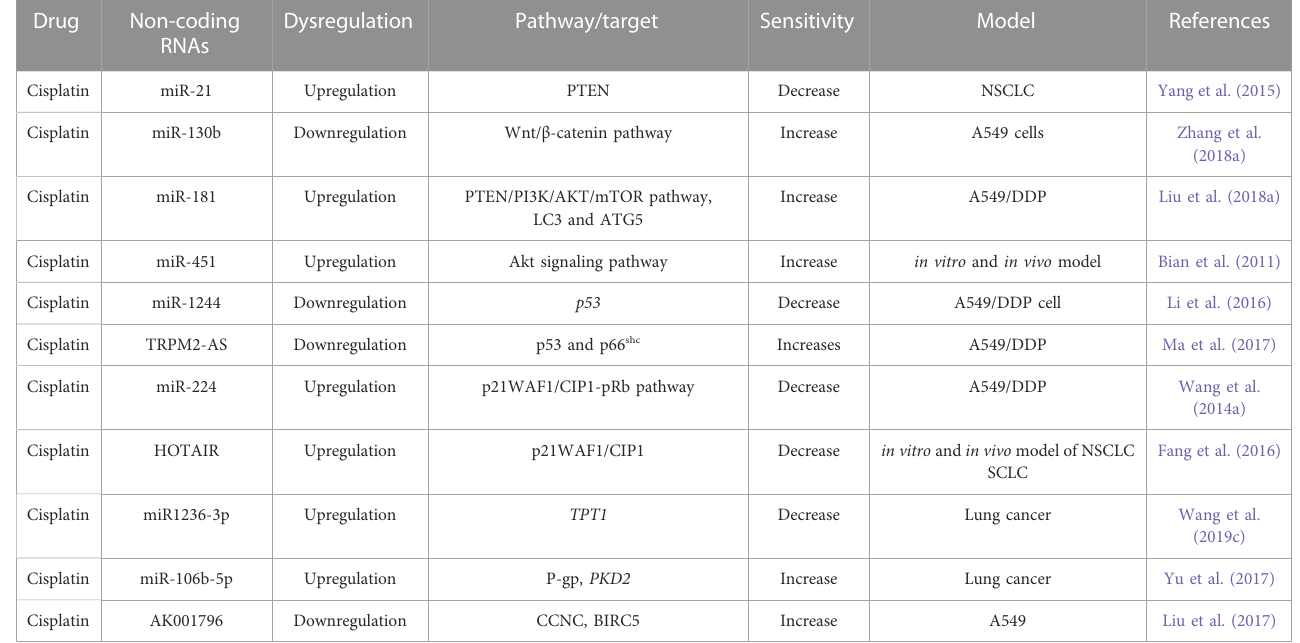
TABLE 4 Non-coding RNAs pro fi le dysregulation alter the factors involved in cell cycle